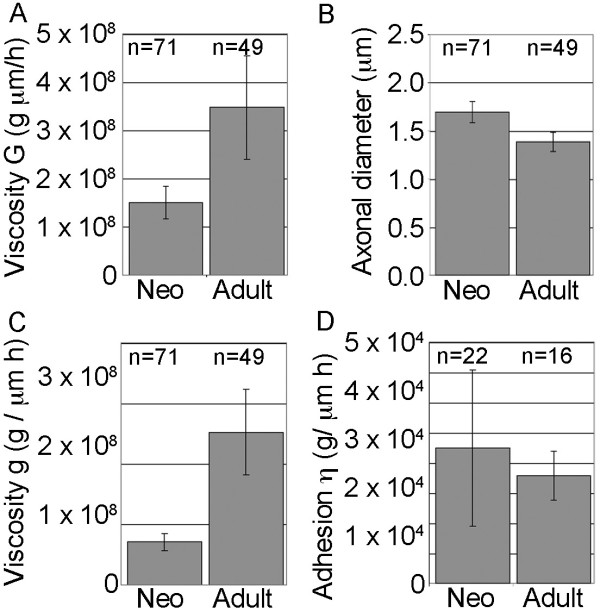
Axonal viscosity increases during aging. A. Axonal viscosity (G) which is an aggregate measure of axonal diameter and intrinsic viscosity (g) increased as a function of age and was significantly different between all groups. B. Axonal diameter decreased as a function of age. C. The intrinsic viscosity (g), increased significantly with aging. D. The strength of adhesions (η) was similar in neurons from neonatal and adults. For all graphs, the average +/- 95% CI is shown and the number of measurements is listed above the bars.